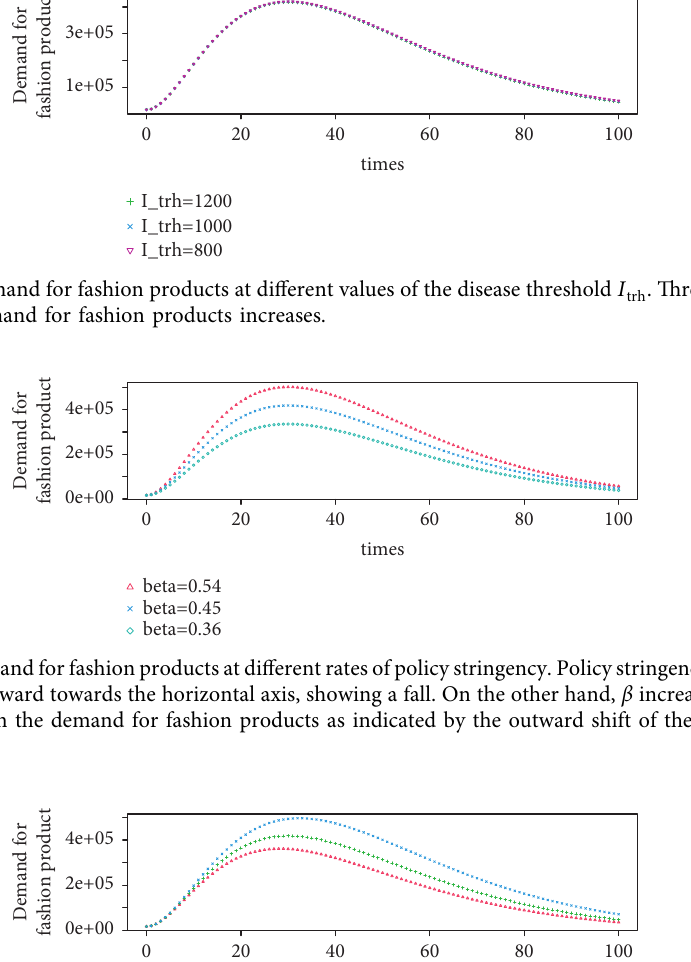
) of policy relaxation. As μ increases from 0.08 to 4 4 increases. 4